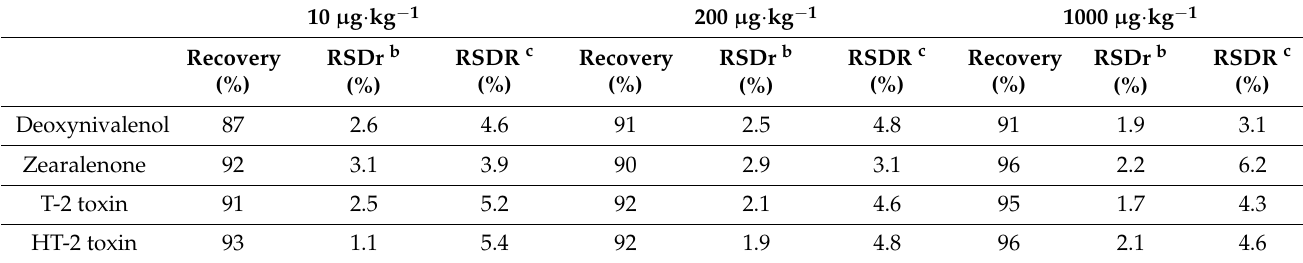
Table 4. Results of recovery and precision of the target mycotoxins in the analysed oats (n = 3).